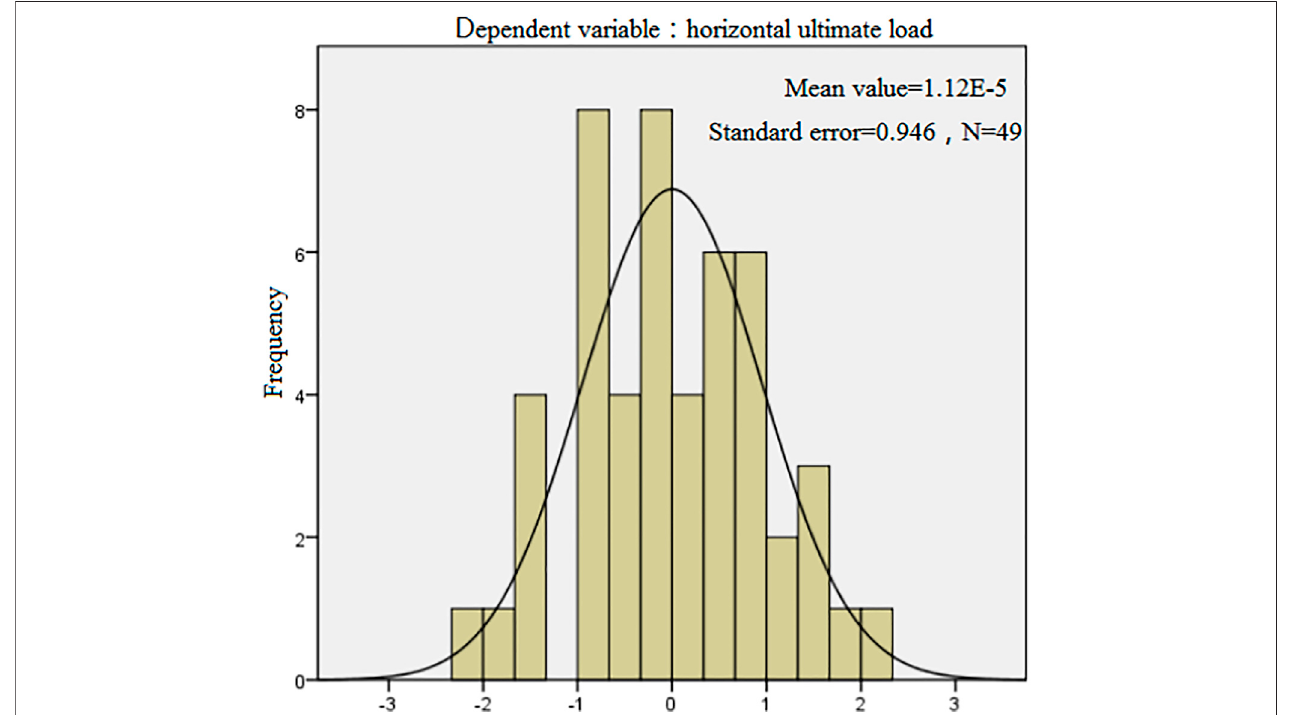
FIGURE 6 | Standardized residual